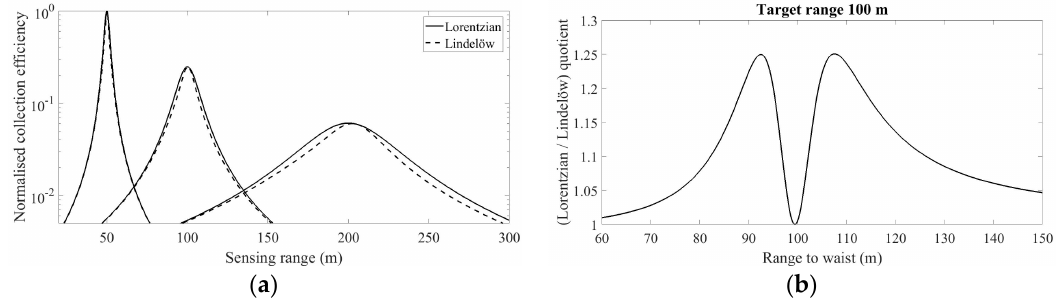
Figure 3. Two models for heterodyne lidar collection efficiency. ( a ) Normalised curves of range dependence for three different fixed focus ranges (50 m, 100 m, 200 m). Lorentzian (solid lines): efficiency scales as the reciprocal of beam area. Lindelöw (dashed lines): modified Gaussian optics/ray optics model proposed by Lindelöw [4]; ( b ) The quotient (Lorentzian efficiency)/(Lindelöw efficiency) for a fixed target range of 100 m and a varying focus range. Wavelength 1.575 μ m, equivalent fibre core beam radius 4.5 μ m, and lens focal length 200 mm (roughly representative of QinetiQ/ZephIR lidar).